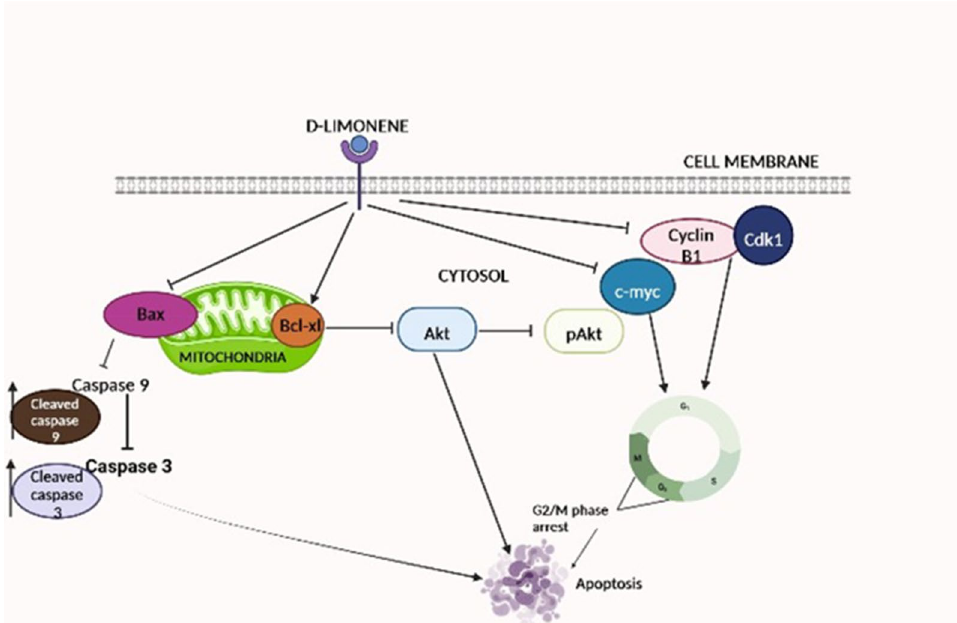
Figure 9. Schematic presentation of the proposed model for anticancerous mechanism of d-limonene in MCF7 breast cancer cells. The diagram indicates initiation of apoptosis by d-limonene regulating apoptosis related molecules leading to G2/M arrest eventually inhibiting cell